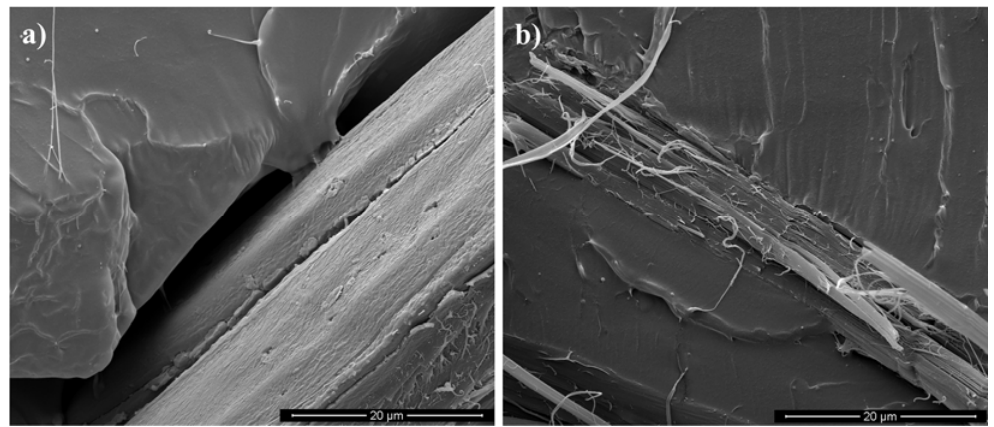
Figure 8. Fracture surfaces showing transverse fibers ‐ polymer matrix interface: ( a ) PLA/Flax and ( b ) PLA/Jute.